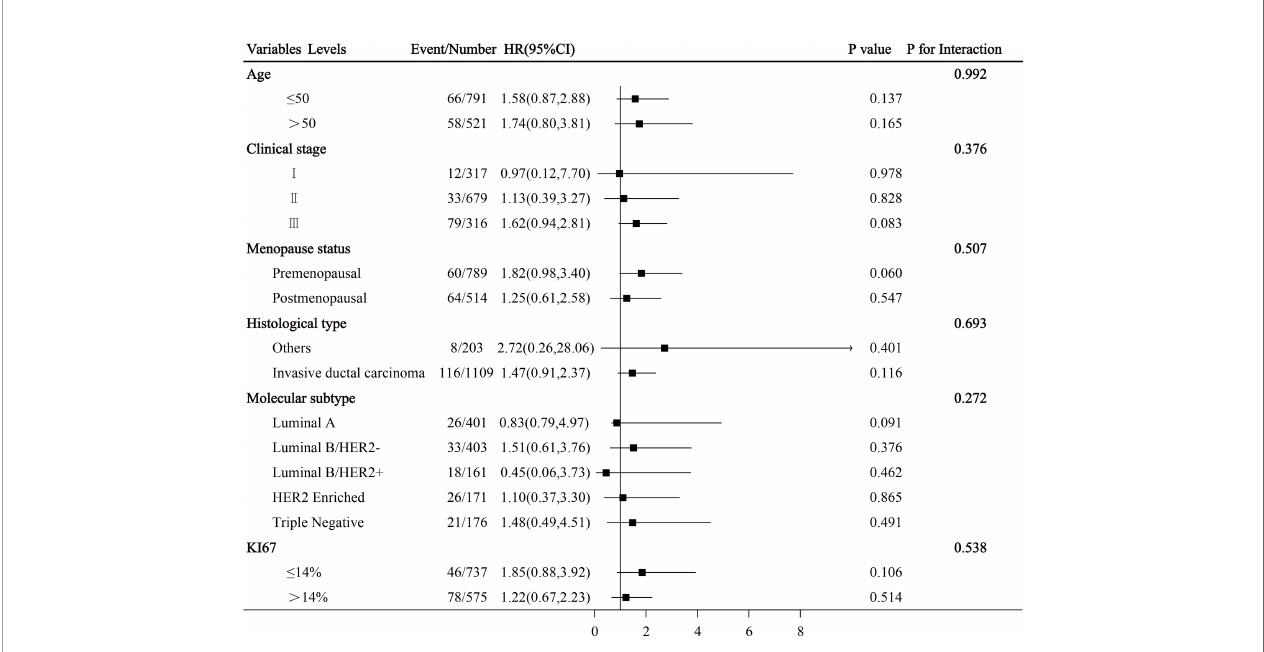
FIGURE 4 | Subgroup analysis of breast cancer-related clinical variables were illustrated in a forest